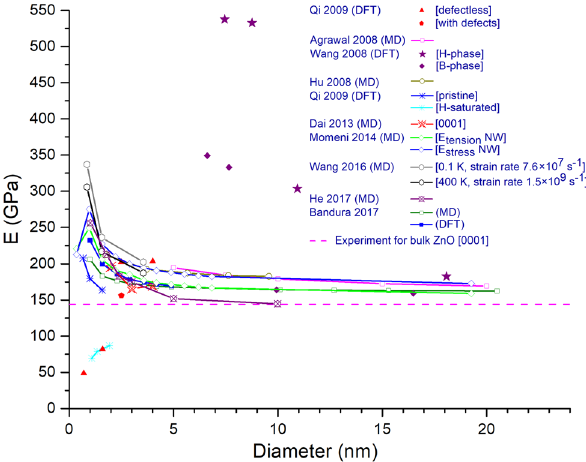
Figure 10: Dependence of calculated Young ’ s moduli ( E ) on NW diameters reported by di ff erent authors. The dashed magenta line at the bottom corresponds to experimentally measured bulk Young ’ s modulus [ 26 ] . Open symbols correspond to MD calculations, and solid symbols correspond to DFT